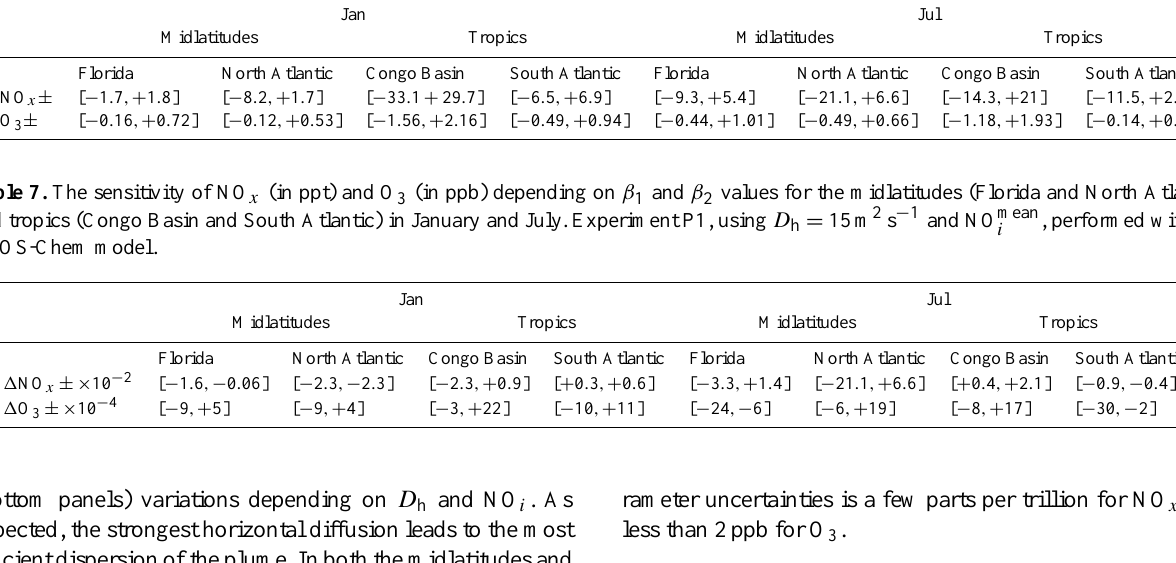
Table 6. The sensitivity of NO x (in ppt) and O 3 (in ppb) depending on the horizontal diffusion coefficient ( D h , m 2 s − 1 ) and on the NO i mixing ratio (ppb) injected by lightning for the midlatitudes (Florida and North Atlantic) and tropics (Congo Basin and South Atlantic) in January and July. Jan